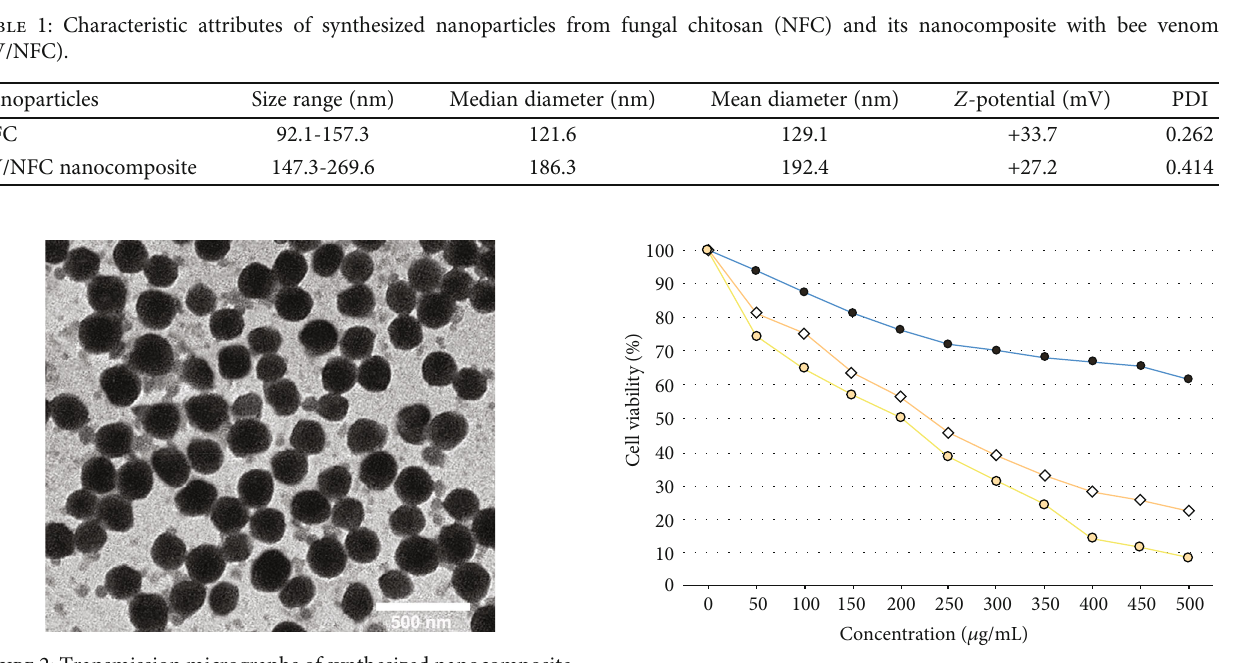
Figure 2: Transmission micrographs of synthesized nanocomposite from fungal chitosan and bee venom.